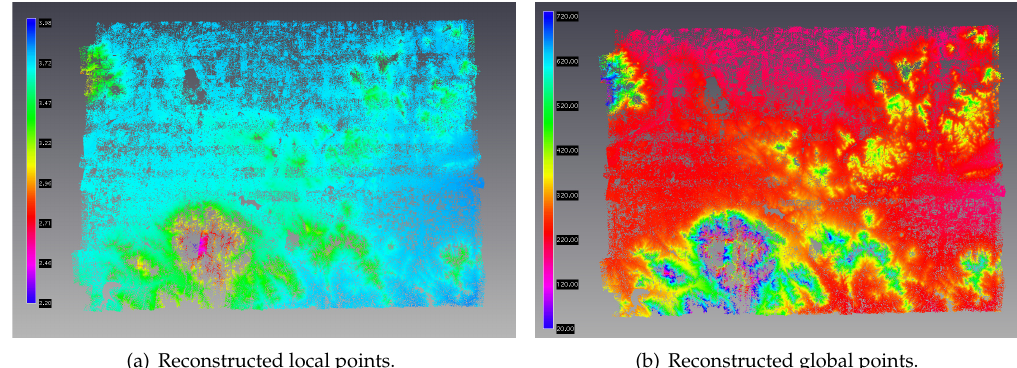
Figure 9. Reconstructed 3D terrain of the Taian dataset in the local and global coordinate systems. The unit of measure of the reconstructed points in the global coordinate system is meters, whereas the local points have no practical meaning due to a lack of scale and origin information. ( a ) and ( b ) are 3D triangulated points of the Taian dataset in the local and global coordinate systems,